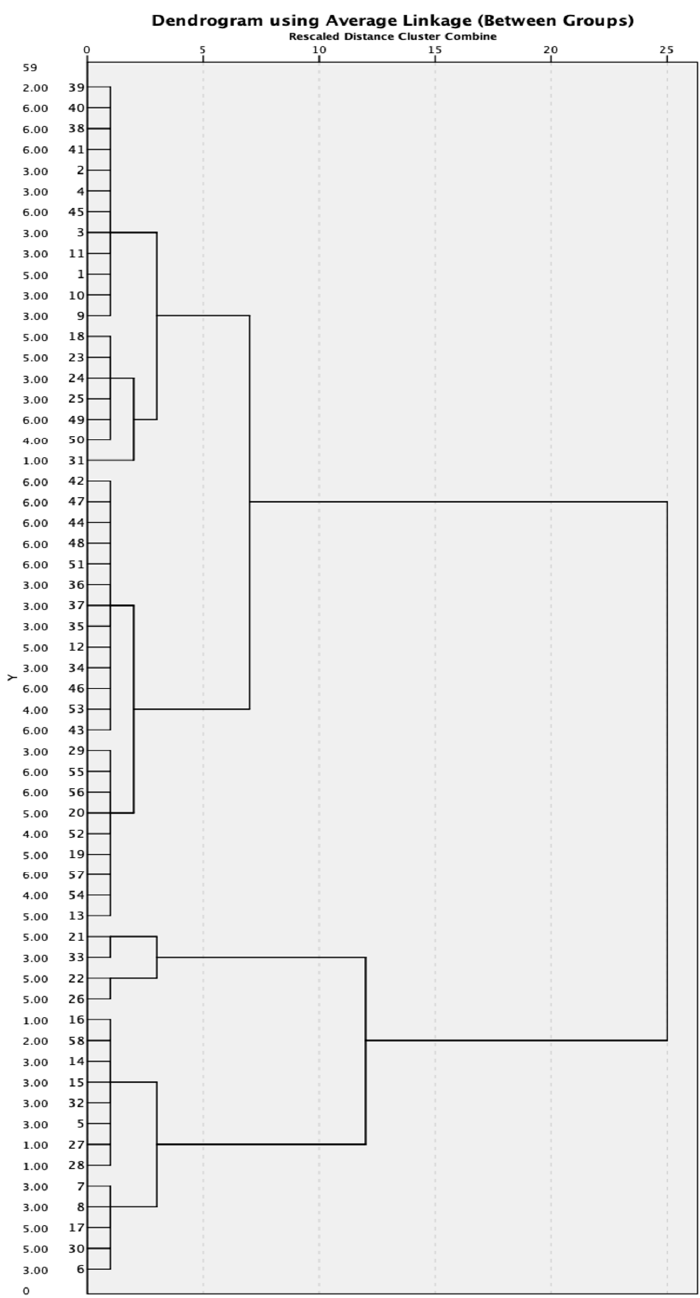
Figure 3. Agglomerative hierarchical clustering of the studied honey samples. The clustering was carried out to investigate the possibility of using the results of the studied parameters to predict the floral and geographical origins of the honey